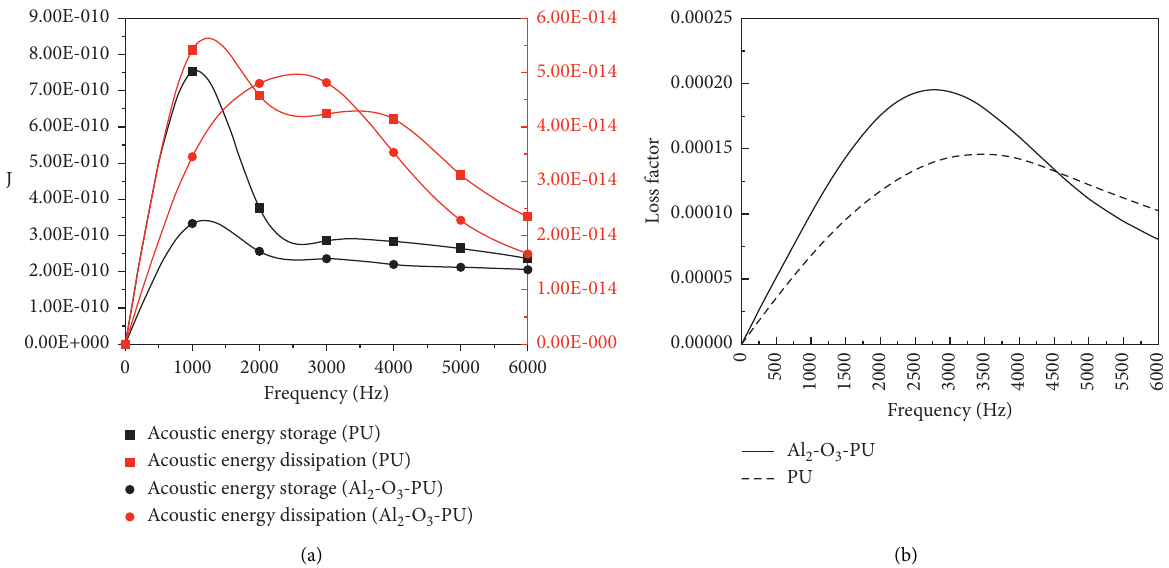
Figure 7: (a) Sound energy storage and sound energy dissipation of single-hole PU and Al sound